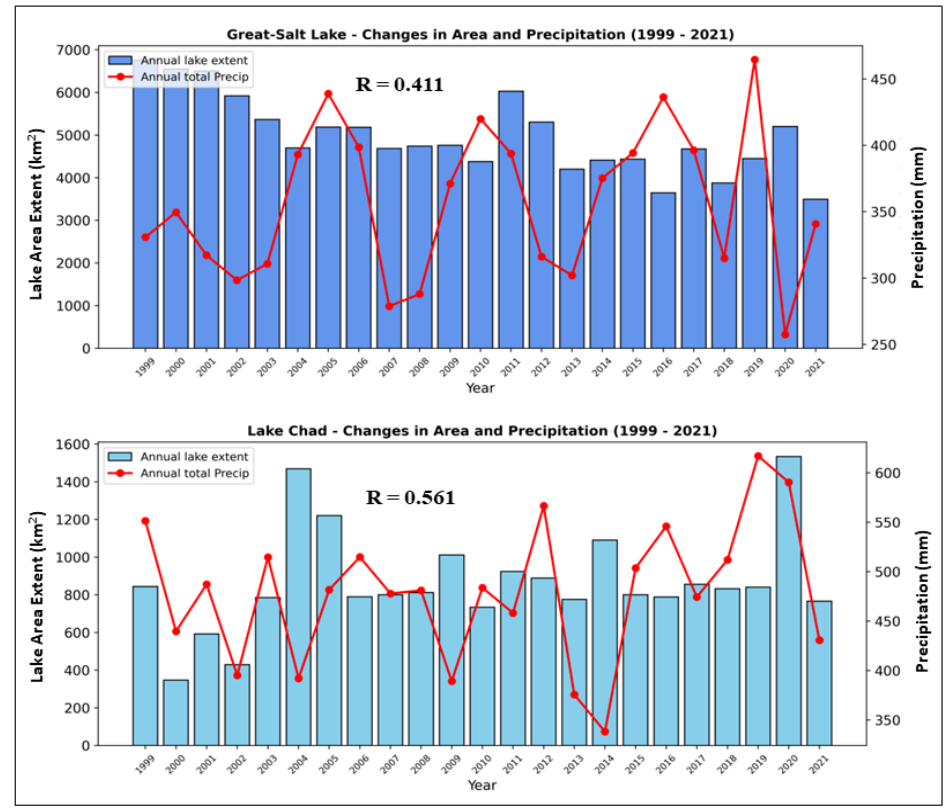
Figure 6. Temporal variation of the annual lake area and precipitation in GSL ( top ) and LC ( bottom ).